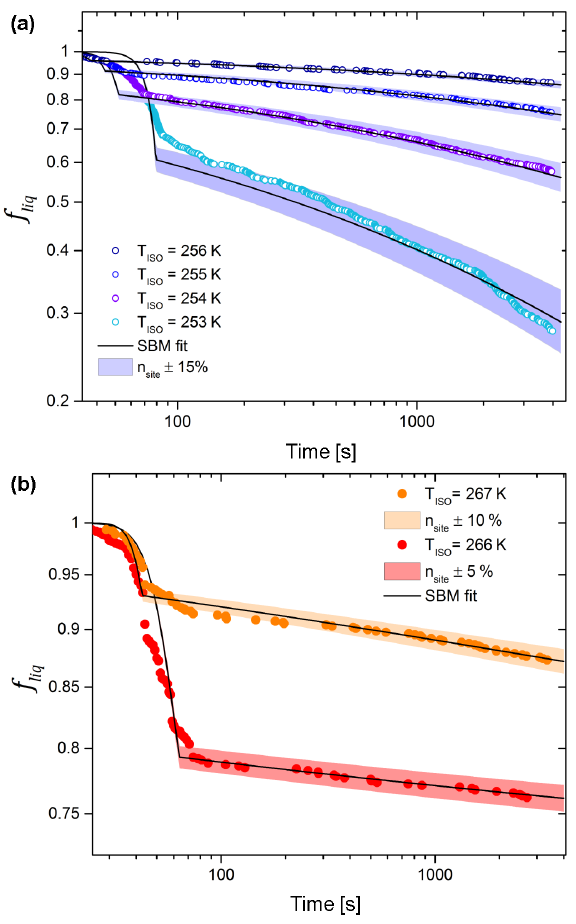
Figure 7. Decay of the fraction of liquid droplets with time for FS02 (a) and FS04 (b) for different T ISO (log–log scale). Solid lines show composite SBM fit with parameters given in Table 2 (see Sect. 7 for detailed discussion). Shaded areas indicate the variabil- ity n site ± (cid:49)n site of a best-fit value, with actual (cid:49)n site given in the legend.